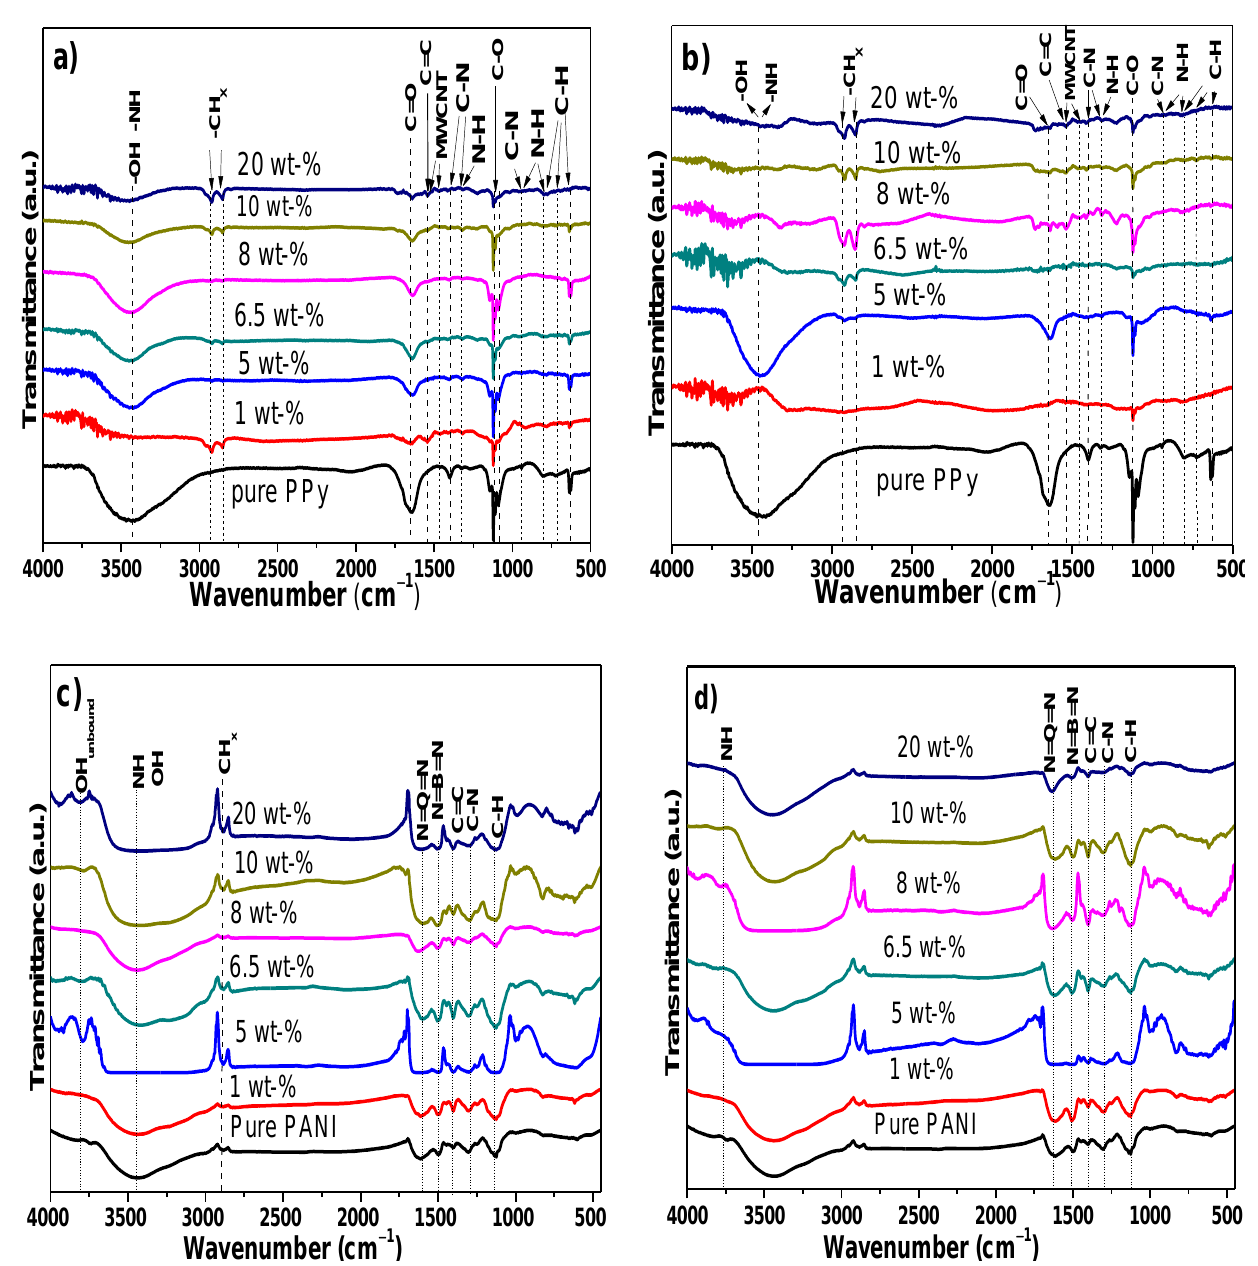
Figure 6. FT-IR spectra acquired from ( a ) comparison of PPy/MWCNTs nanocomposites with pure PPy; ( b ) PPy/commercial MWCNTs nanocomposites, ( c ) comparison PANI/MWCNT nanocomposites with pure PANI; ( d ) PANI/commercial MWCNTs nanocomposites.